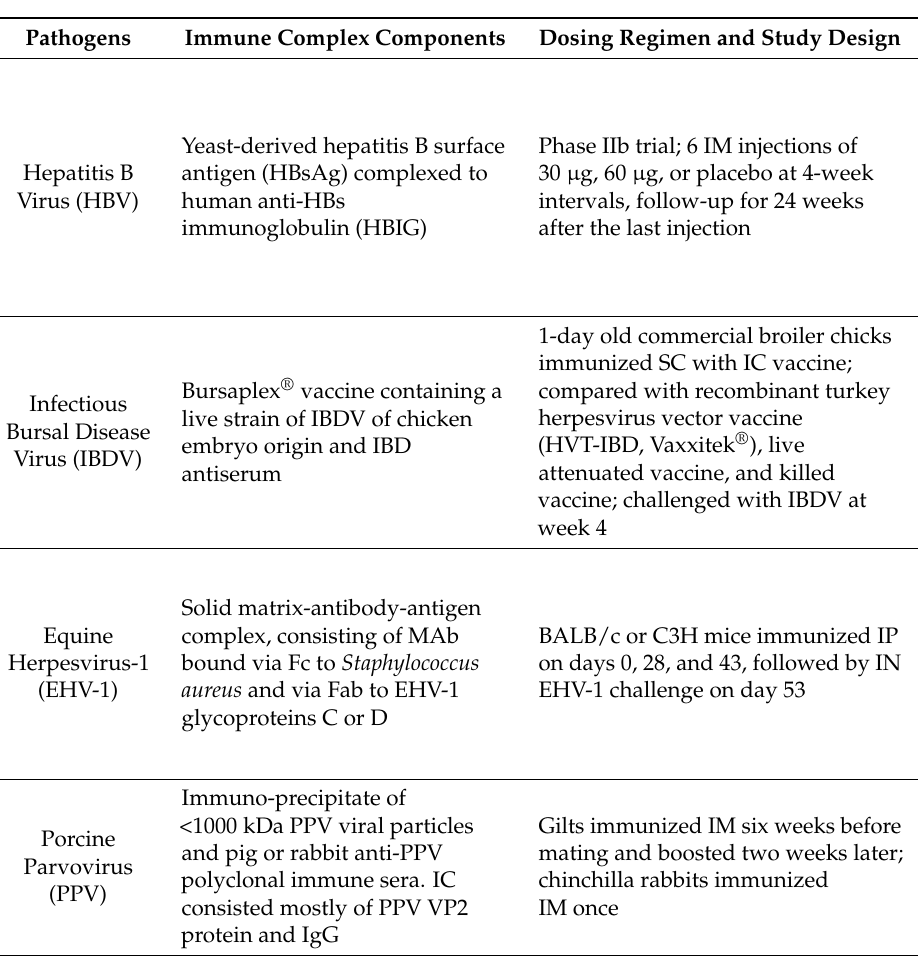
Table 1. Immune complex (IC) vaccines against pathogens other than